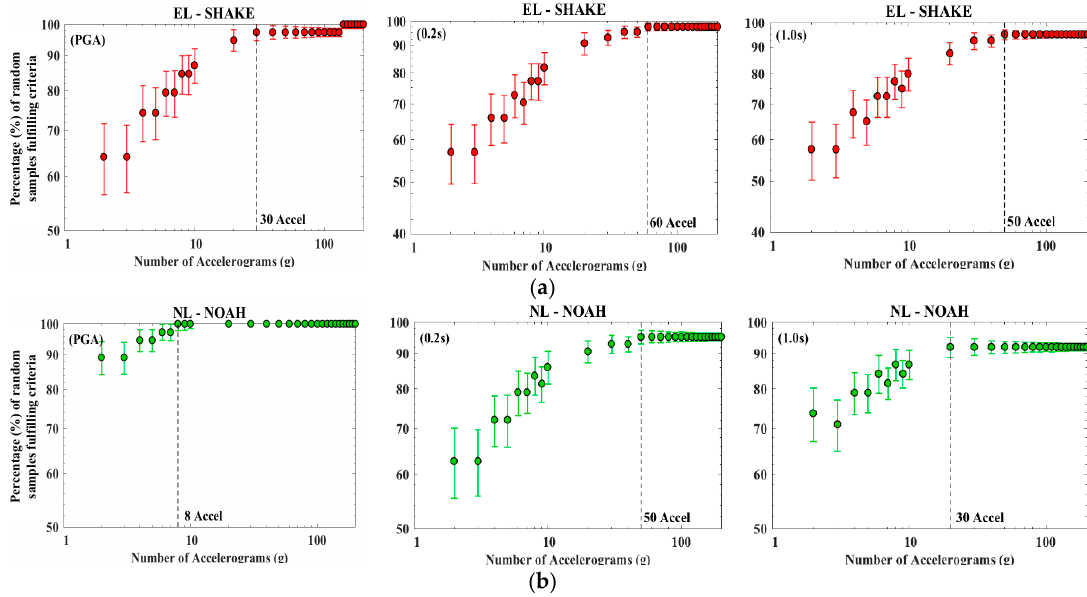
Figure 17. ( a ) Efficiency curves: the median of AF ( f ) is estimated from n accelerograms randomly selected in our set of stochastic time histories, this is repeated 1000 times, and the percentage of samples where median AF ( f ) is within a 10% error with respect to the true median value (estimated over the full set of time histories) is determined. n varies between 2 and 200. ( a ) SHAKE case; ( b ) NOAH case. Table 4. Minimum number of records, n, required to predict a median value of AF ( f ) within ± 10% of the true value for three different spectral periods (PGA, 0.2 s and 1.0 s). Code n ,